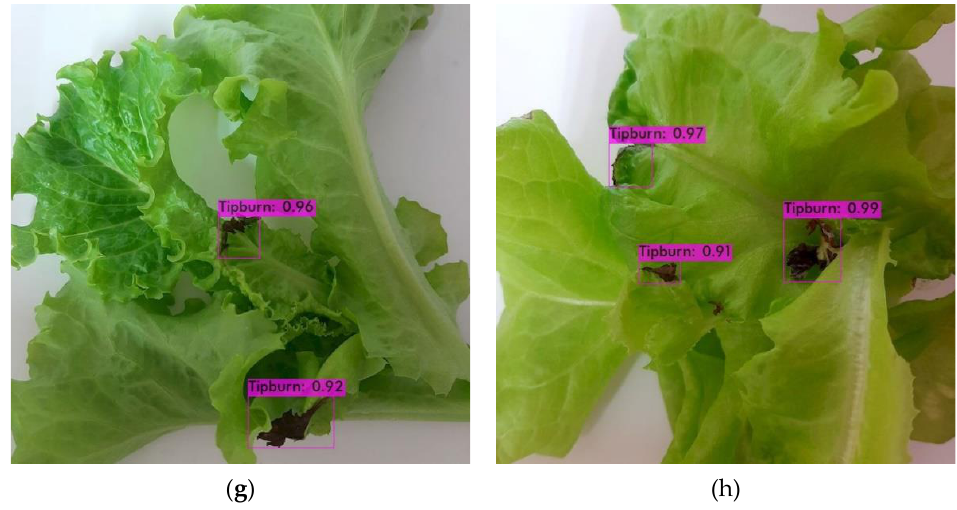
Figure 6. Detection of tip-burn under white light conditions from ( a , b ) manually labelled; ( c , d ) YOLOv5; ( e , f ) CenterNet; ( g , h ) YOLOv4.